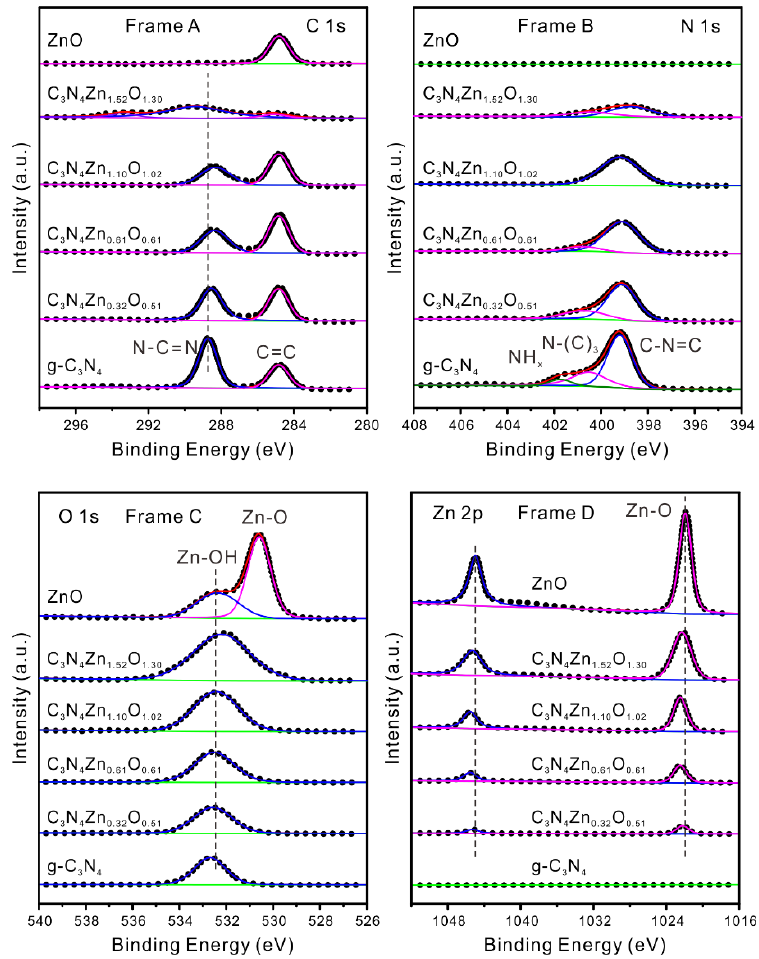
Figure 4. XPS spectra of g-C 3 N 4 , C 3 N 4 Zn x O y , and ZnO samples. Frame A: C 1s photoelectron energies; Frame B: N 1s photoelectron energies; Frame C: O 1s photoelectron energies; Frame D: Zn 2p photoelectron